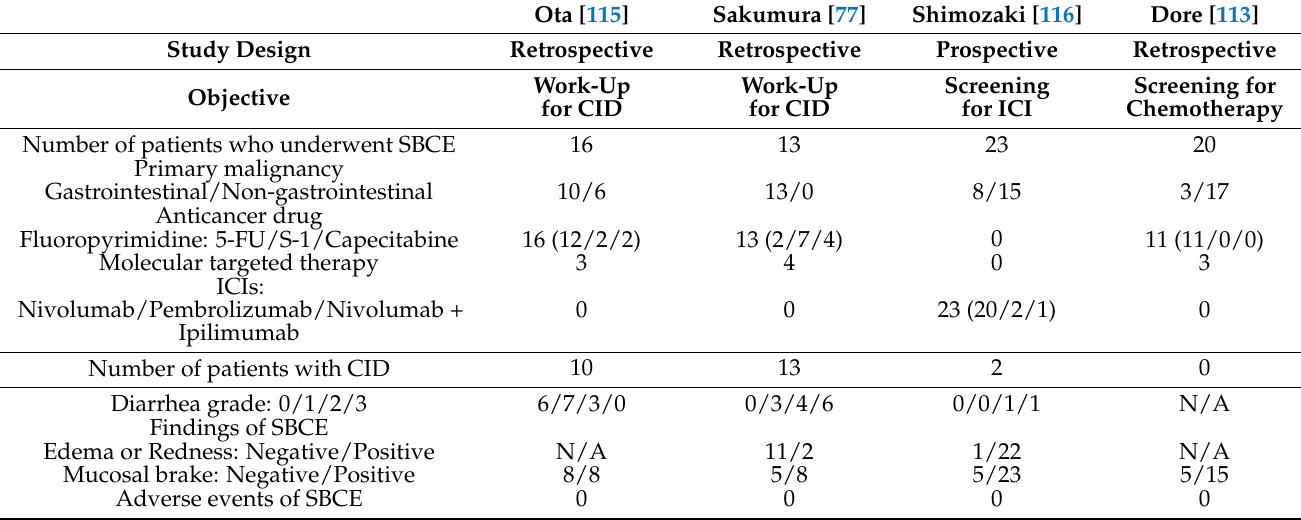
Table 3. Summary of SBCE studies in patients receiving anticancer